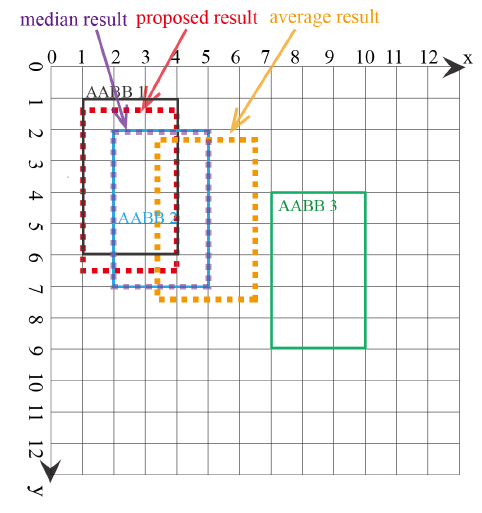
Figure 7. Second example of fusing three AABBs with one outlier.